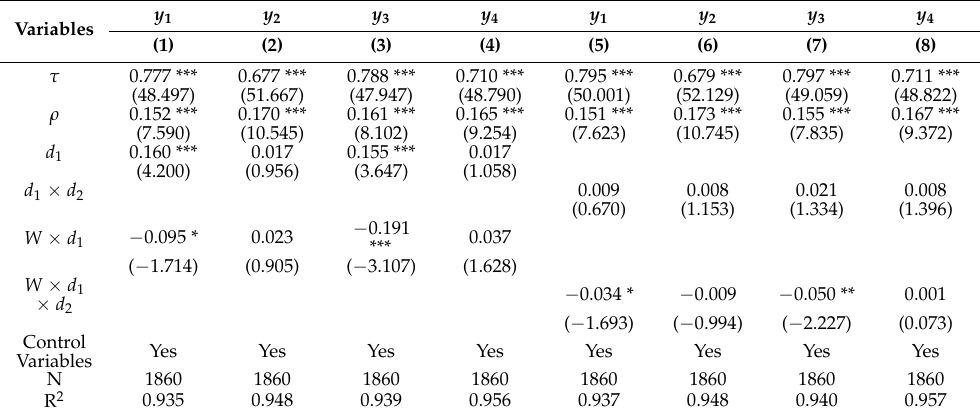
Table 4. Results of the dynamic spatial econometric